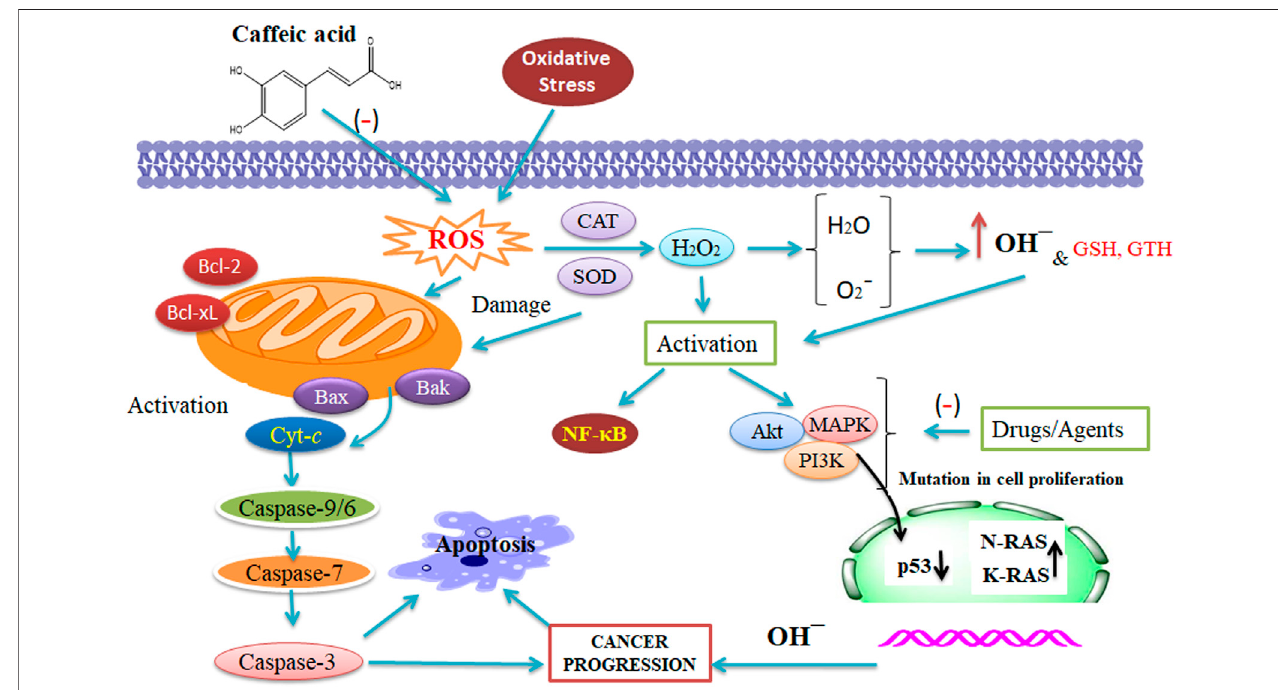
FIGURE 2 | Synergistic action of caffeic acid (CA) with anti-tumor therapy that affects the reactive oxygen species, catalase, and superoxide dismutase. The combinedresultofCAandCAFrevealstheirpotentialagainsttumors andevaluatesthemolecular mechanismsofthecombinationwithaseveral-target approach(Maity et al., 2021 and Alam et al., 2022). This fi gure was drown by ChemBioDraw.